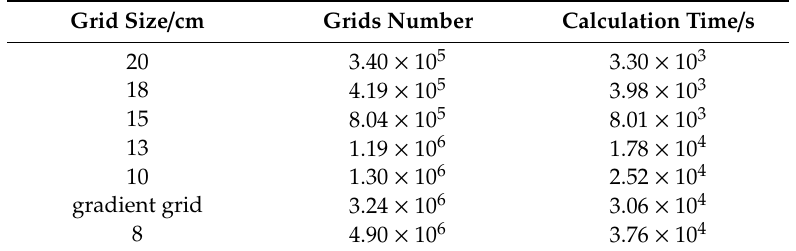
Figure 5. Peak overpressure versus scaled distance under di ff erent grid sizes. Table 10. Grids number and calculation time of di ff erent grid sizes when time step is 1 µ